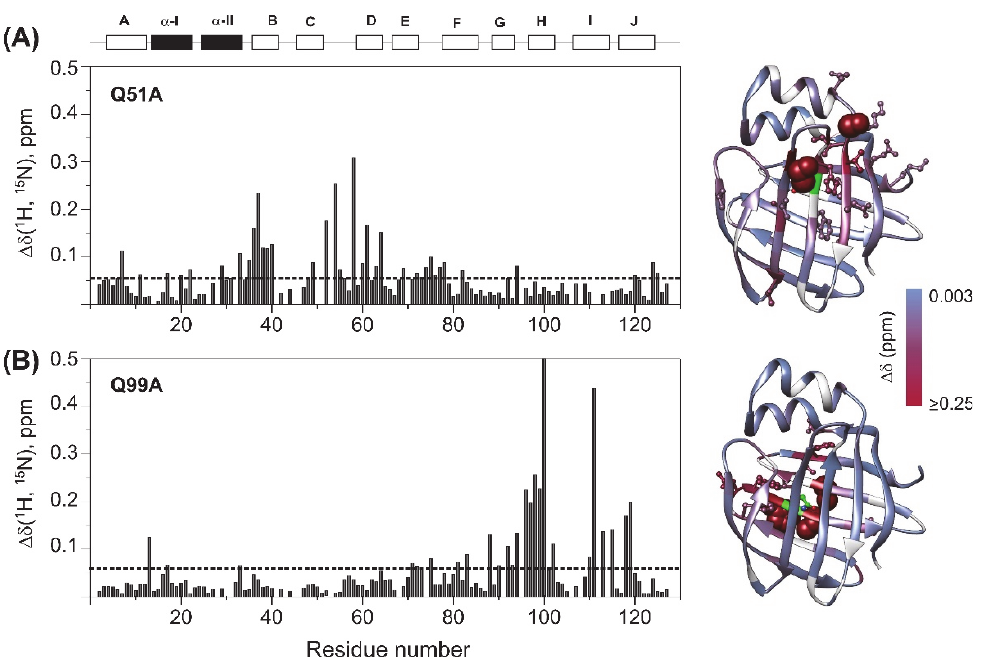
Figure 3. Backbone amide chemical shift differences between wild ‐ type and ( A ) Q51A, ( B ) Q99A apo human I ‐ BABP (283 K). Combined ( 1 HN, 15 N) chemical shifts were calculated using the equation of Δδ 1 HN, 15 N = √ [( Δδ HN ) 2 +(w 1 * Δδ N ) 2 ] , where w 1 (=0.154) is a weight factor determined using the BioMagResBank chemical shift database [42]. The dashed line corresponds to the mean value. Secondary structural elements are indicated at the top. Values of Δδ 1 HN, 15 N are mapped on the ribbon diagram of wild ‐ type human I ‐ BABP (PDB: 1O1U [15]) in a blue ‐ to ‐ red gradient. Residues exhibiting Δδ 1 HN, 15 N > 0.25 ppm (arbitrary limit) are highlighted as spheres, whereas those exceeding the mean by more than half of the standard deviation are shown in a ball ‐ and ‐ stick representation. The position of the mutations is indicated in green. Residues with no available data are colored in gray.